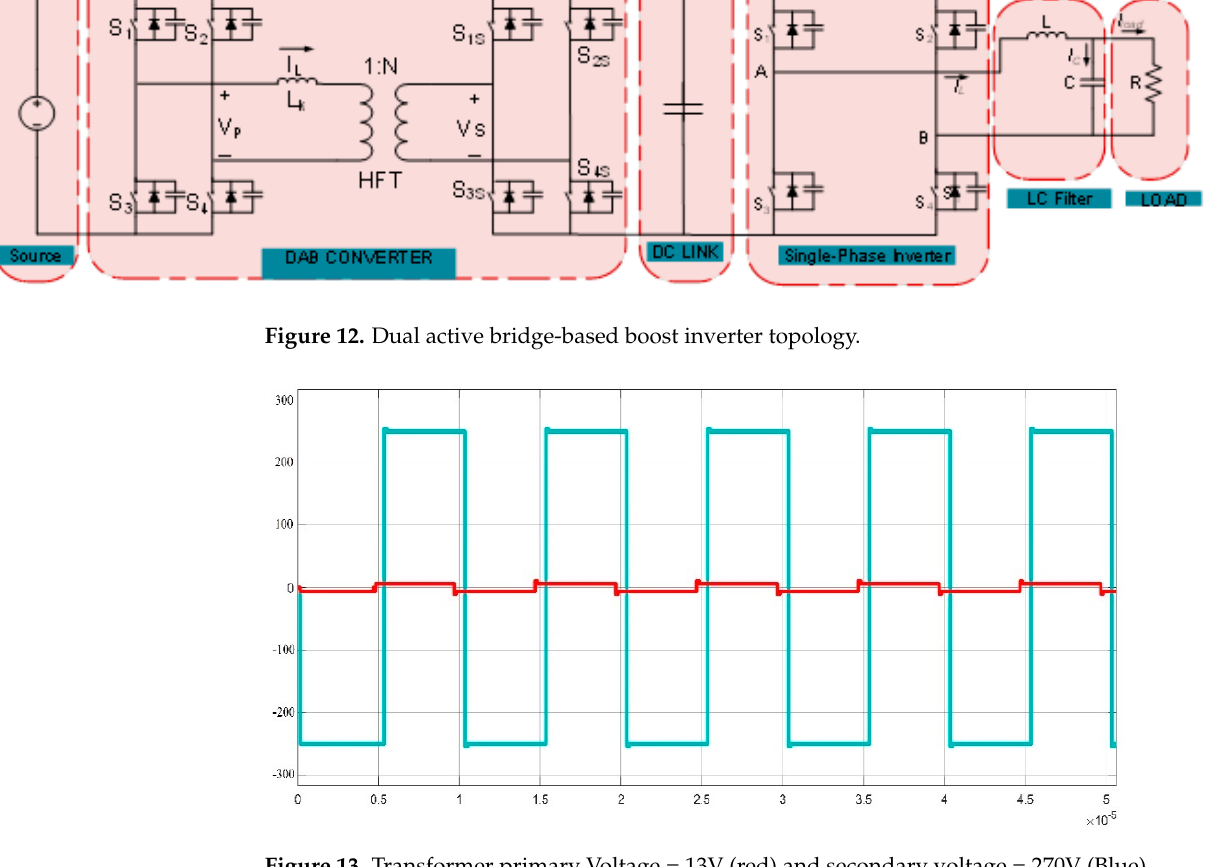
Figure 13. Transformer primary Voltage = 13V (red) and secondary voltage = 270V (Blue). Energies 2022 , 15 , 8944